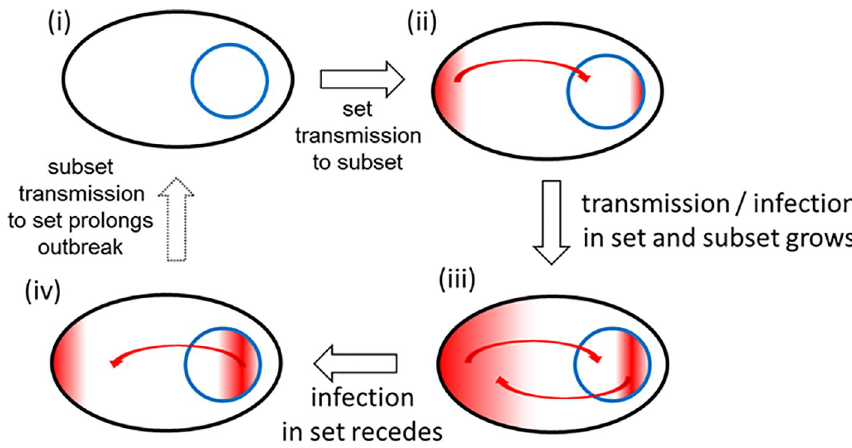
Fig 4. HCWs as a microcosm of society during an epidemic. Inter-relationship between set (national population) and subset (HCWs) during different pandemic phases. Infections indicated by red colour.